Question: Describe this figure in one sentence.
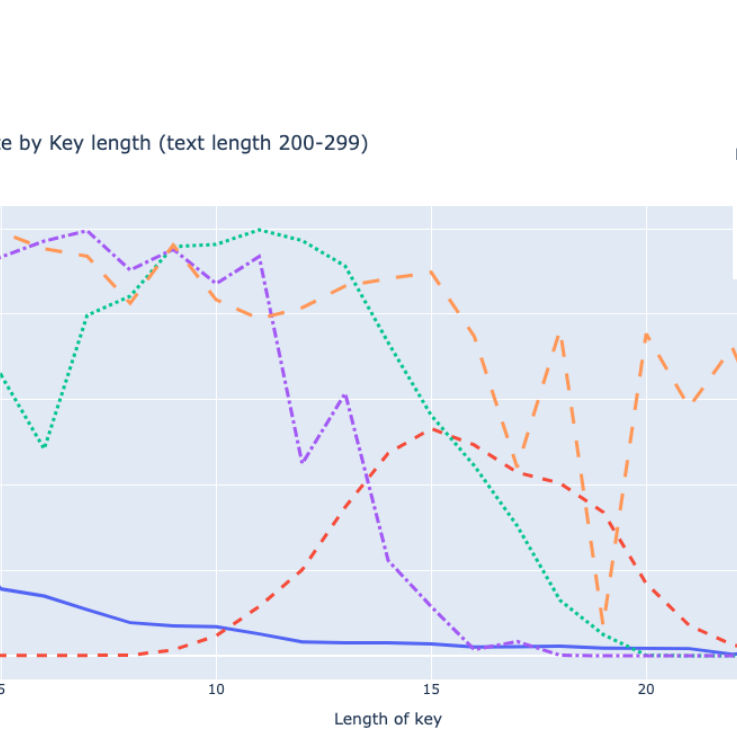
Answer: Accuracy rate by key length for 200 ≤N ≤299